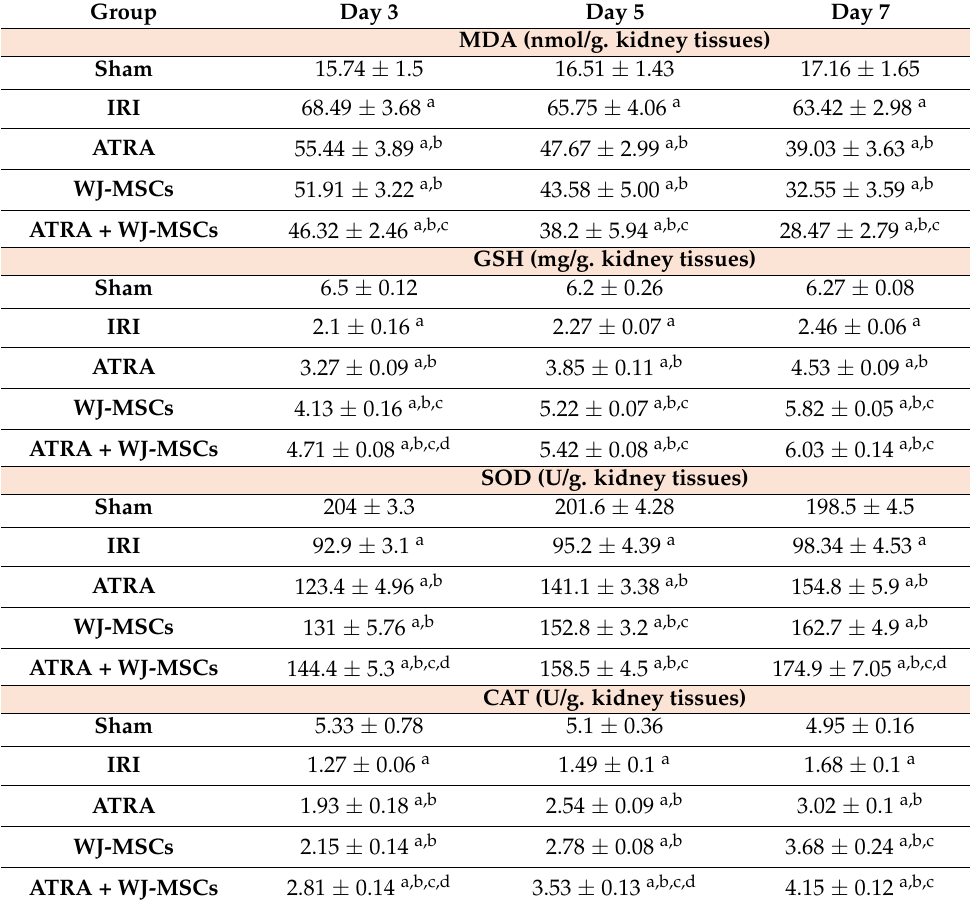
Table 2. Effect of pretreatment of WJMSCs with ATRA on markers of oxidative stress (MDA, GSH, SOD and CAT) levels in kidney tissues (n =